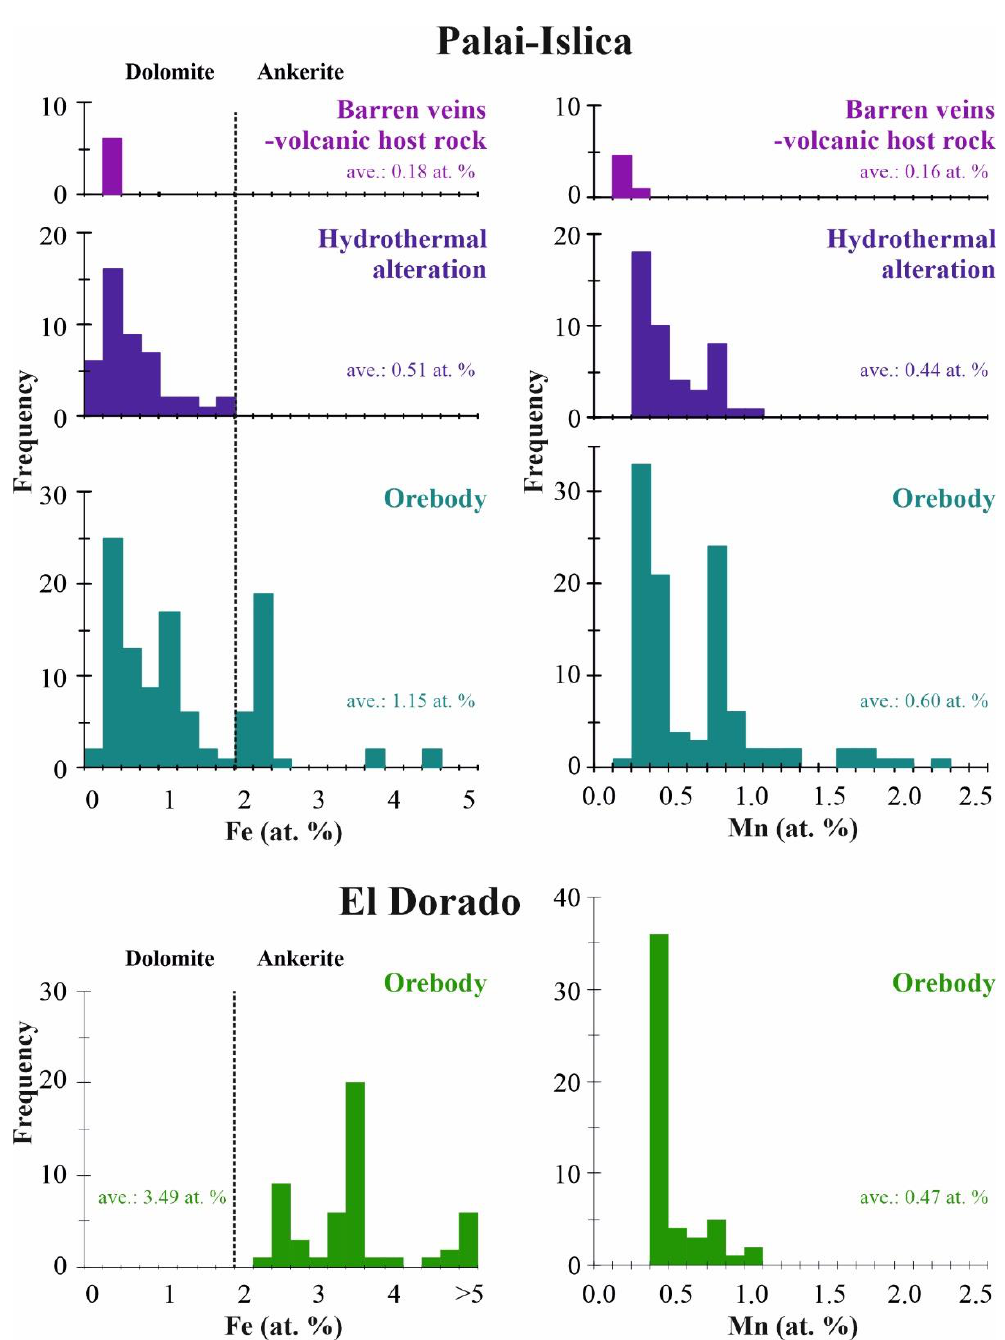
Figure 4. Frequency histograms for the Fe and Mn content in atomic % for the dolomite/ankerite analyzed from the Au-Cu epithermal deposit (Palai-Islica-SE Spain, and El Dorado-central Chile). Back-scattered SEM images of ankerite at El Dorado reveal irregular and oscillatory chemical zonation (Figure 7). The oscillatory rims have a relatively low Fe content, whereas irregularly zoned cores have a significantly higher Fe and Mn content.